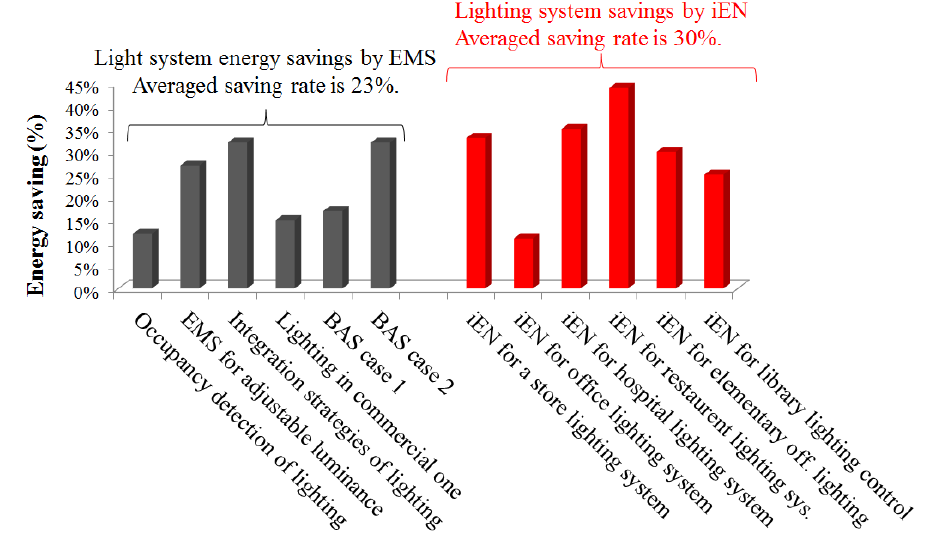
Figure 7. Comparison of energy savings of lighting system by applying EMS and